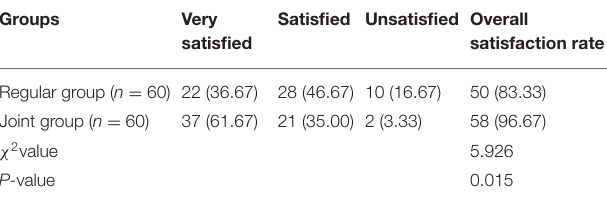
TABLE 3 | Comparison of nursing satisfaction of the two groups ( n ,